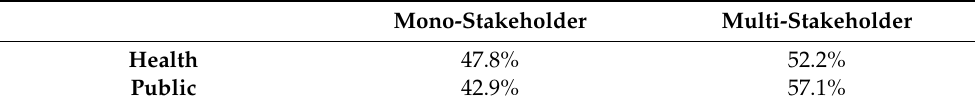
Table 4. Mono-stakeholder/multi-stakeholder evaluation approach.